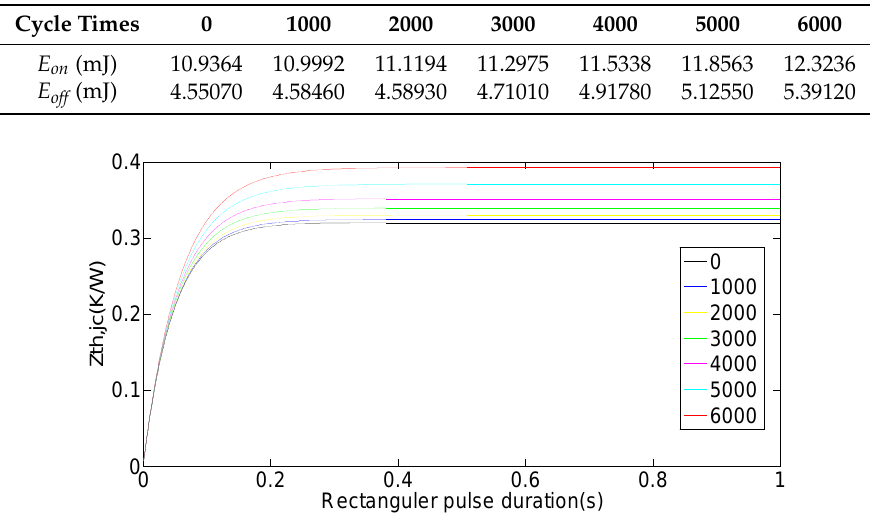
Table 2. The turn-on loss E on and turn-off loss E off of IGBT under different aging states.